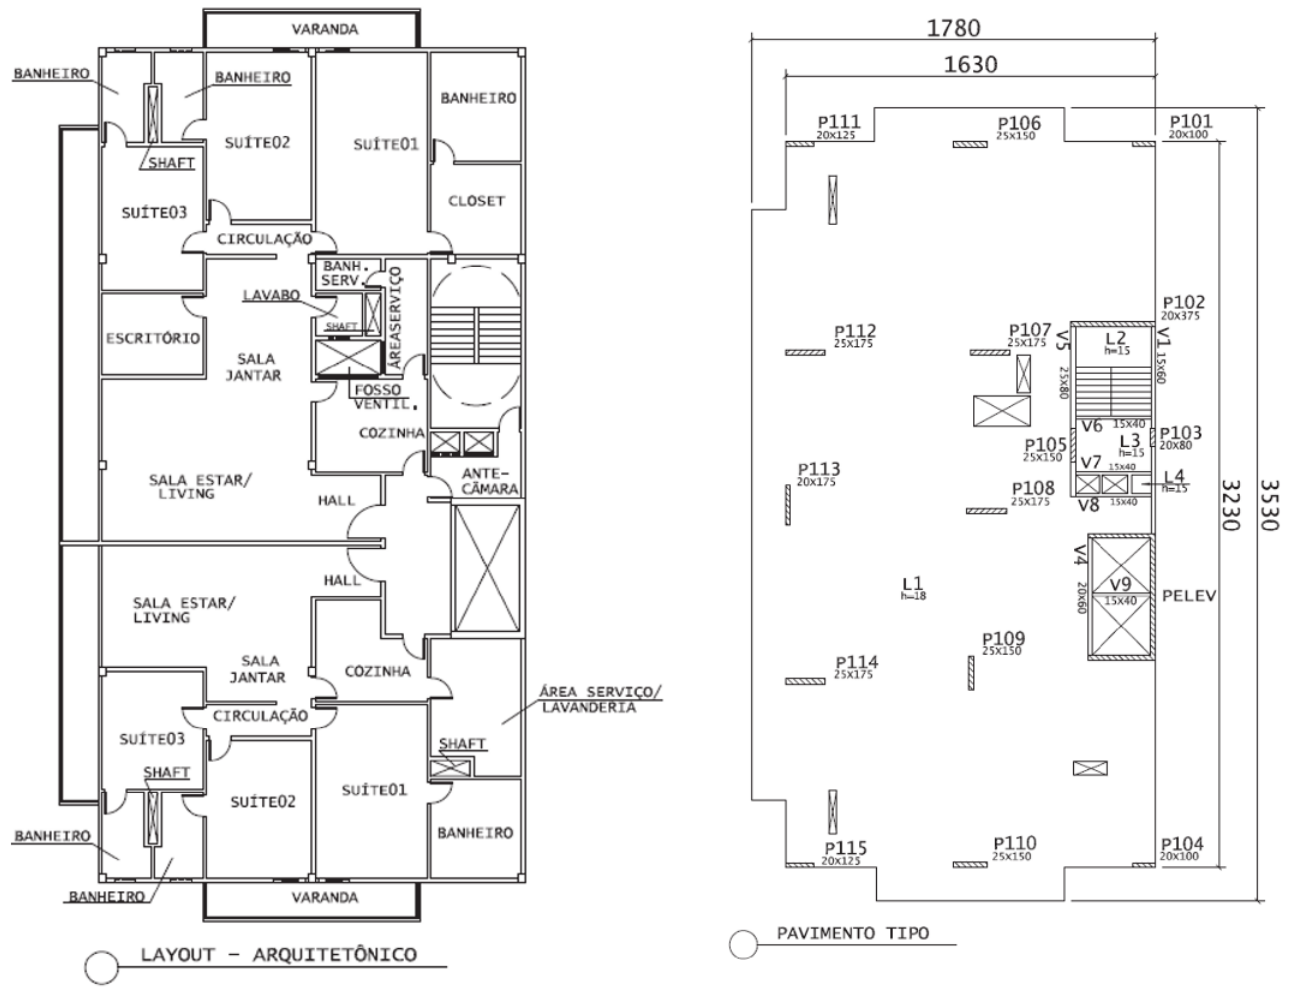
Figura 1 Layout arquitetônico e lançamento estrutural do pavimento